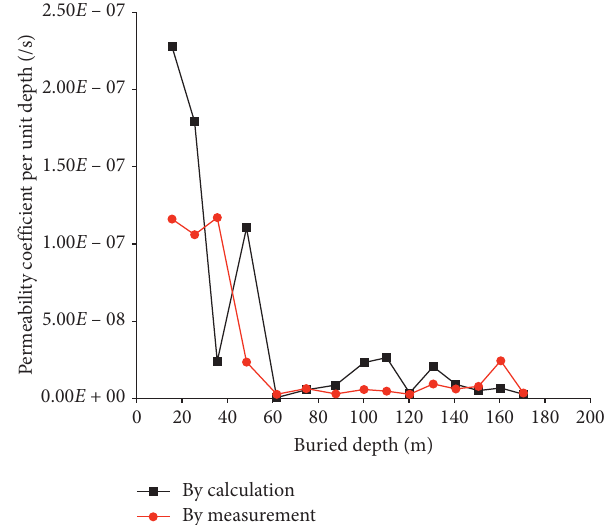
Figure 8: Permeability coefficient per unit depth with buried Table 2: The fracture data for sections 3 and 14 of the borehole.